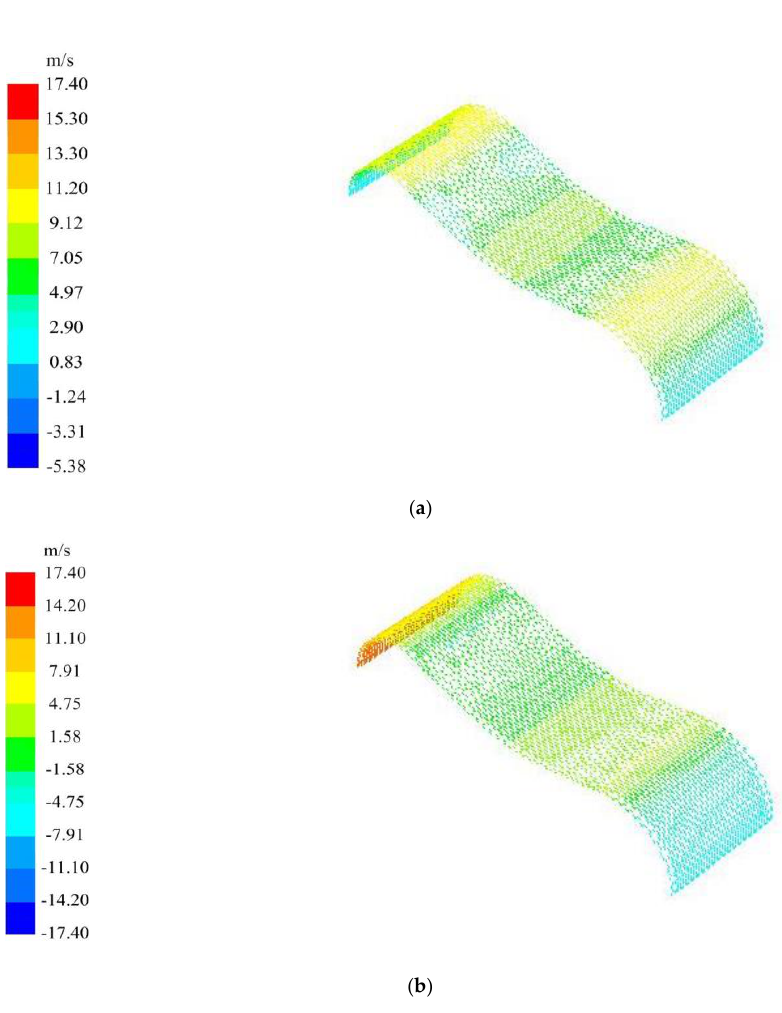
Figure 15. Tangential velocity of particles in the optimized flow passage.